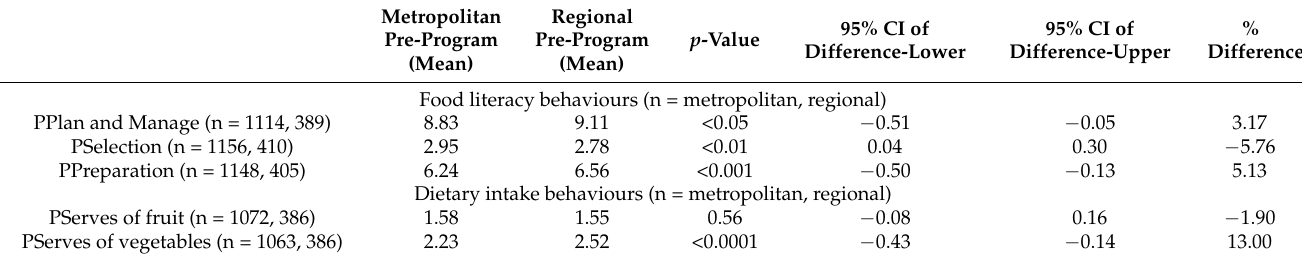
Table 2. Two-tailed t-tests comparing metropolitan vs. regional pre-program scores for the three food literacy behaviour domains and change in self-reported dietary intake of fruits and vegetables at